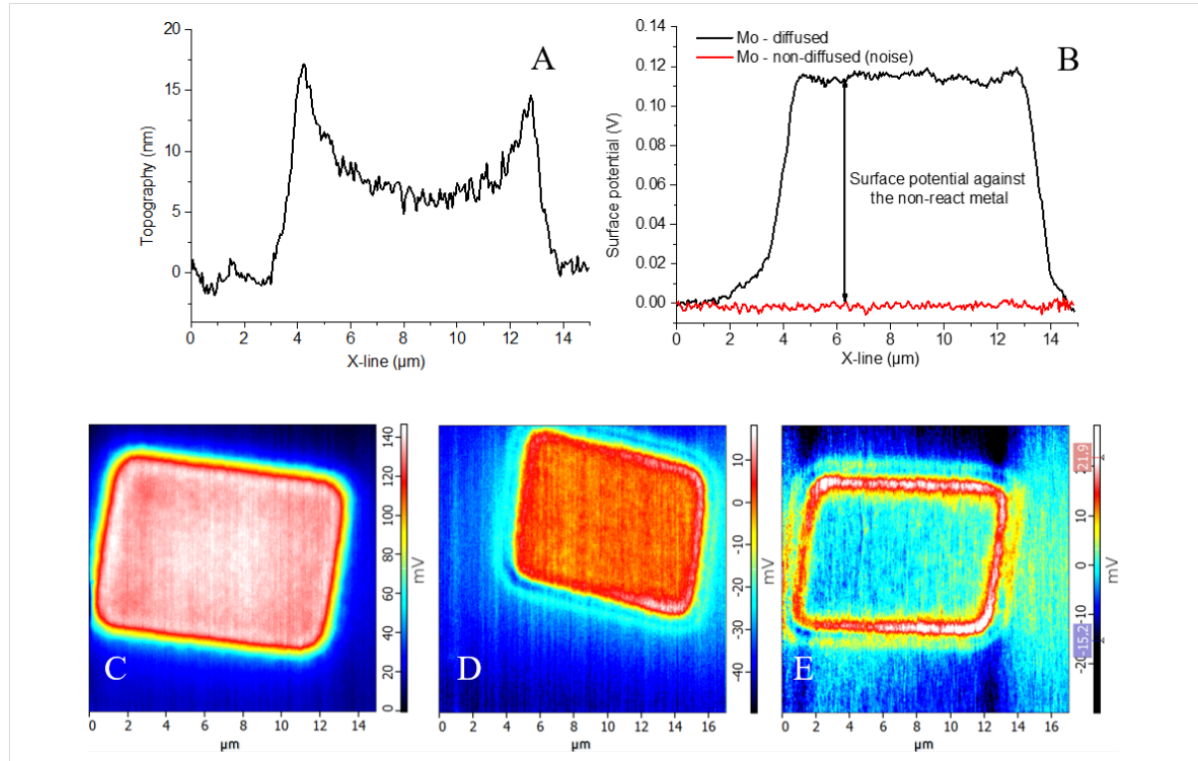
Figure 7: (A) Topographical and (B) surface contact potential profiles of the 9 nm irradiated Mo layer; maps of the surface contact potential measured by the KPFM for the e-beam formed NIs on the Mo layer/Bi 2 Se 3 for Mo thickness values of (C) 9 nm, (D) 17 nm, and (E) 63